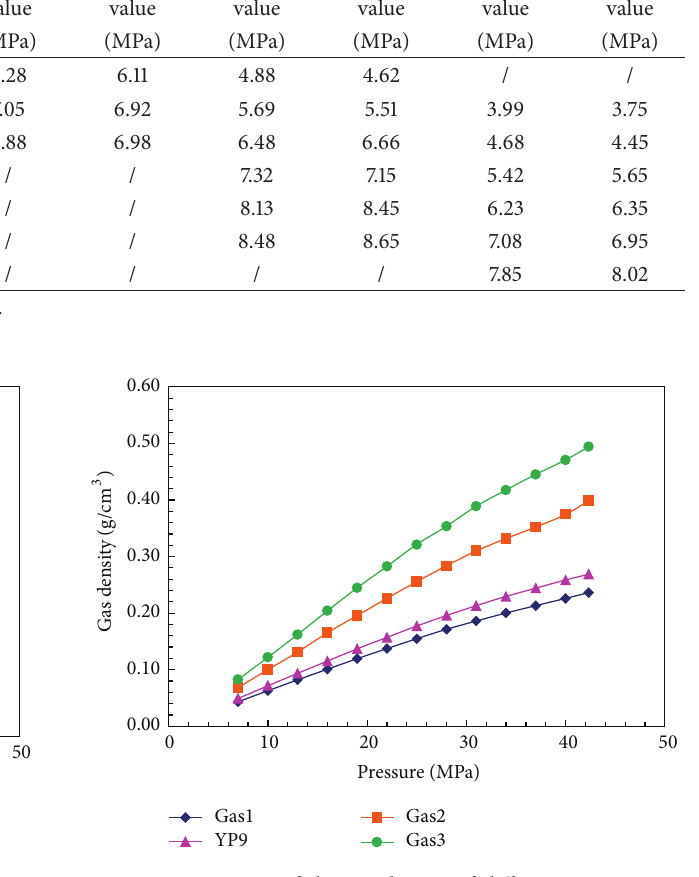
Figure 11: Variation of the gas density of different CO 2 content natural gas samples with pressure at 127.5 ∘